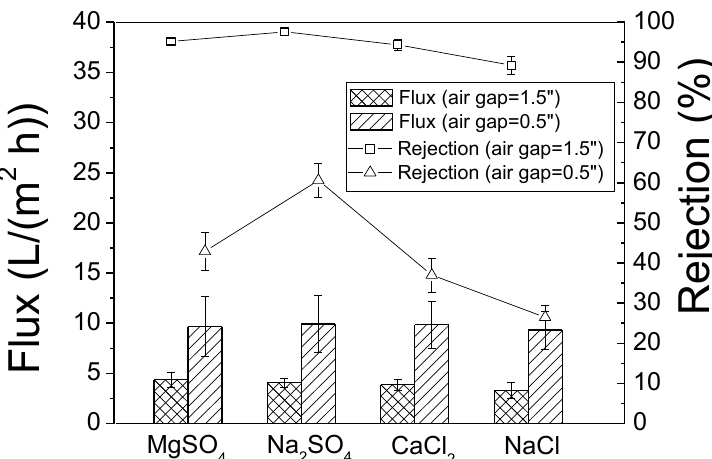
Figure 13. Salt rejection and water flux of PBI HF modules fabricated with different air gaps (1.5” and 0.5”) or (3.8 cm and 1.3 cm) (Test condition: 2000 ppm single salt solution, 300 psi or 20.7 bar, pH 7.0 and 25 ± 2 °C).